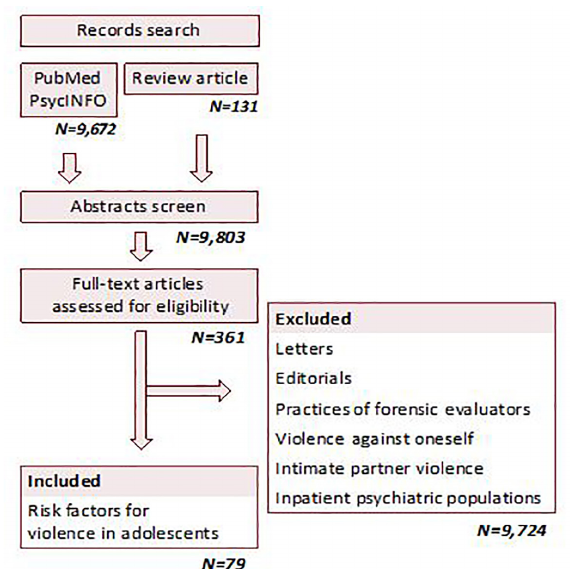
Figure 1. Search